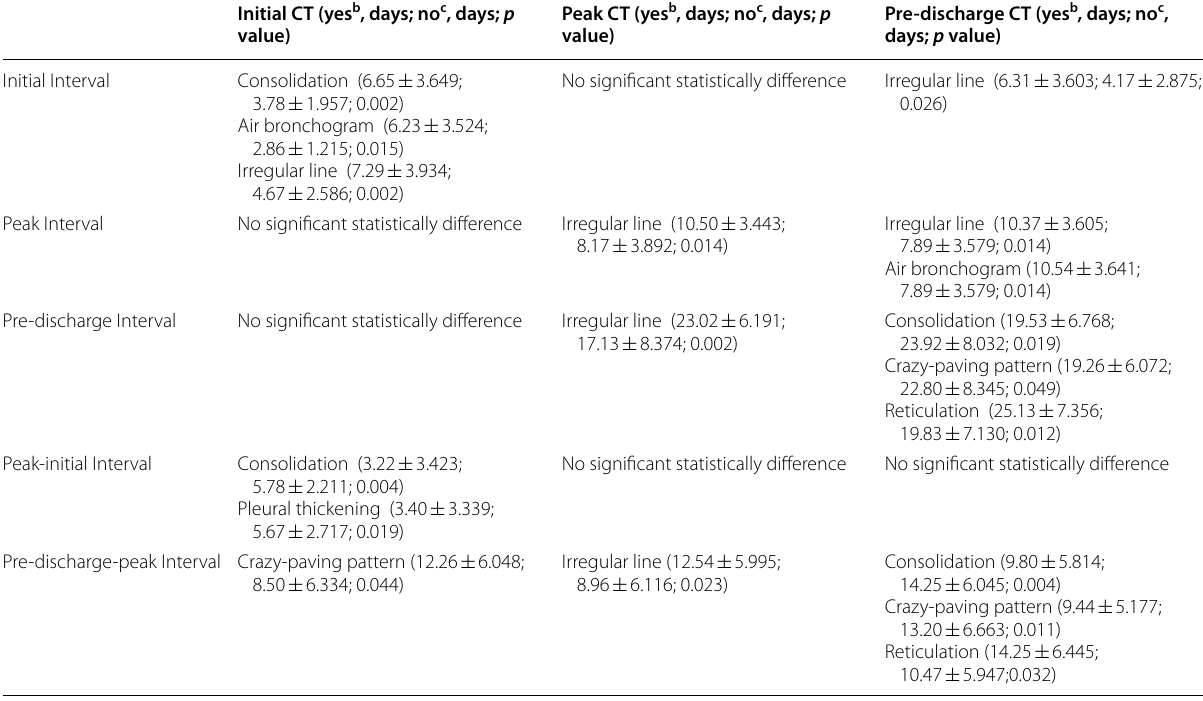
a The other imaging findings not shown in the table had no significantly statistically difference in intervals